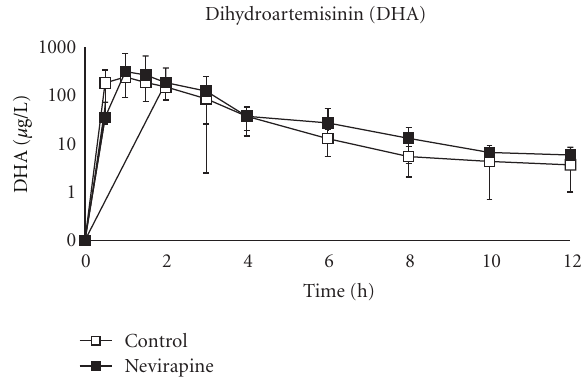
Figure 2: Mean plasma concentration versus time profile of dihydroartemisinin (0–12